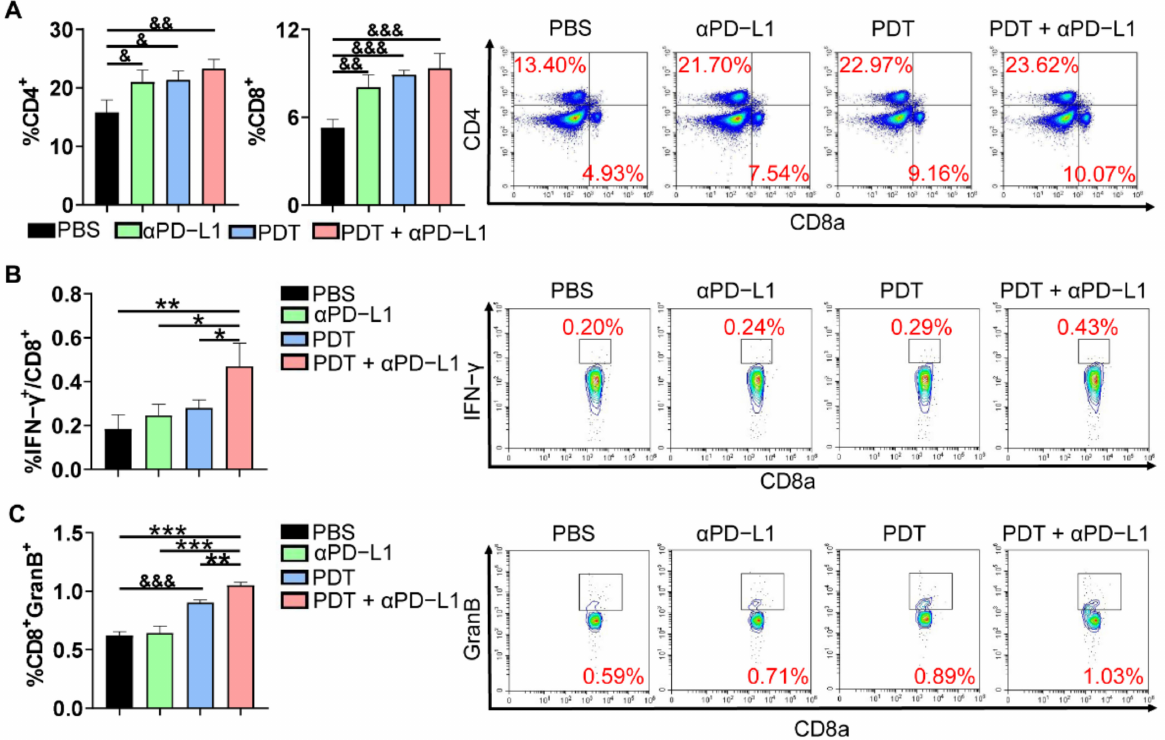
Figure 6. Flow cytometry analysis of various immune cells in the spleens in the 4T1–bearing mice following different treatment. ( A ) Percentage of CD4 + and CD8 + cells in spleens, ( B ) IFN– γ + in CD8 + cells and ( C ) CD8 + GranB + in spleens, respectively. The therapeutic regimen was shown in Supplementary Figure S5. The representative flow cytometric histograms and their gating strategies are shown on the right. Data are presented as mean ± SD ( n = 3). * p < 0.05, ** p < 0.01 and *** p < 0.001 compared with the PDT + α PD–L1 group. & p < 0.05, && p < 0.01 and &&& p < 0.001 compared with the PBS